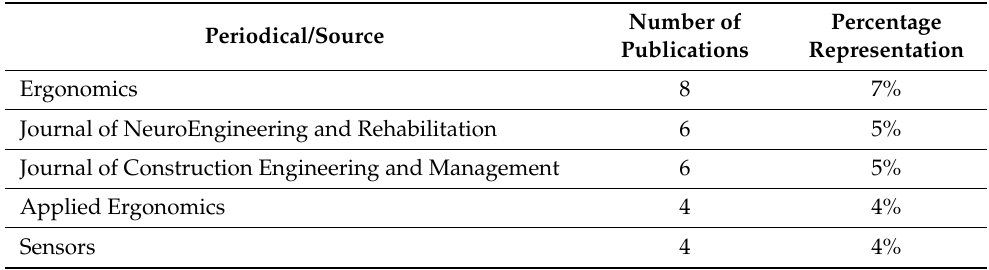
Table 2. List of publications by periodical or focus of the source with the highest number of publica- tions. Source: own